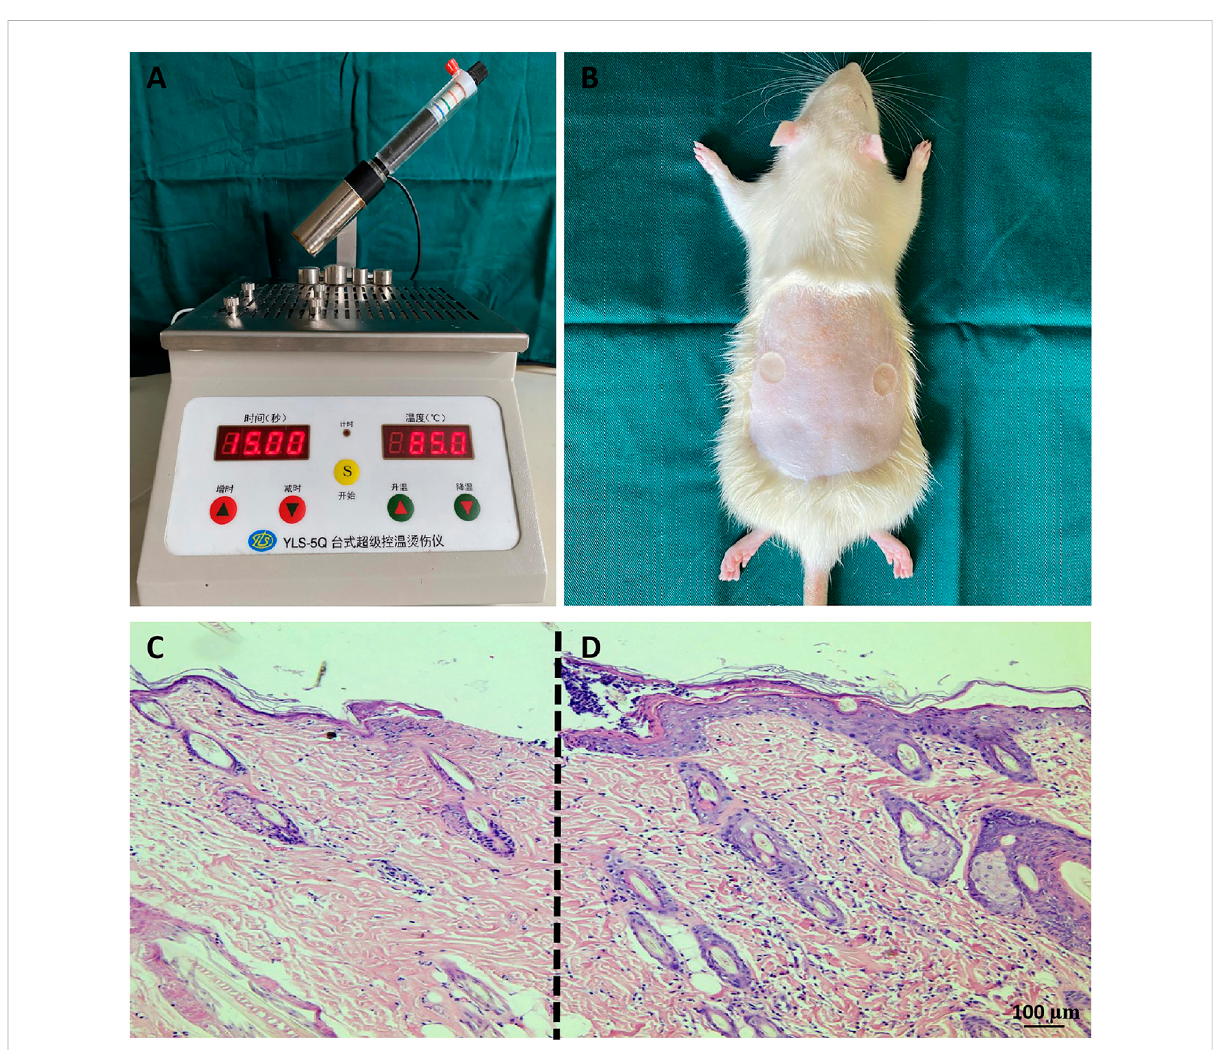
FIGURE 1 Ratdeepsecond-degreescaldmodels (A,B) Establishmentofdeepsecond-degreeburns. (C,D) H&Estainingoftissuesections.Comparedwith the normal skin tissue at the edge of the burn wound (D) , the surface of the wound (C) was thinner, the tissue was edematous, the cells were obviously shrunken, and the sweat glands and hair follicles were damaged. The scale bar represents 100